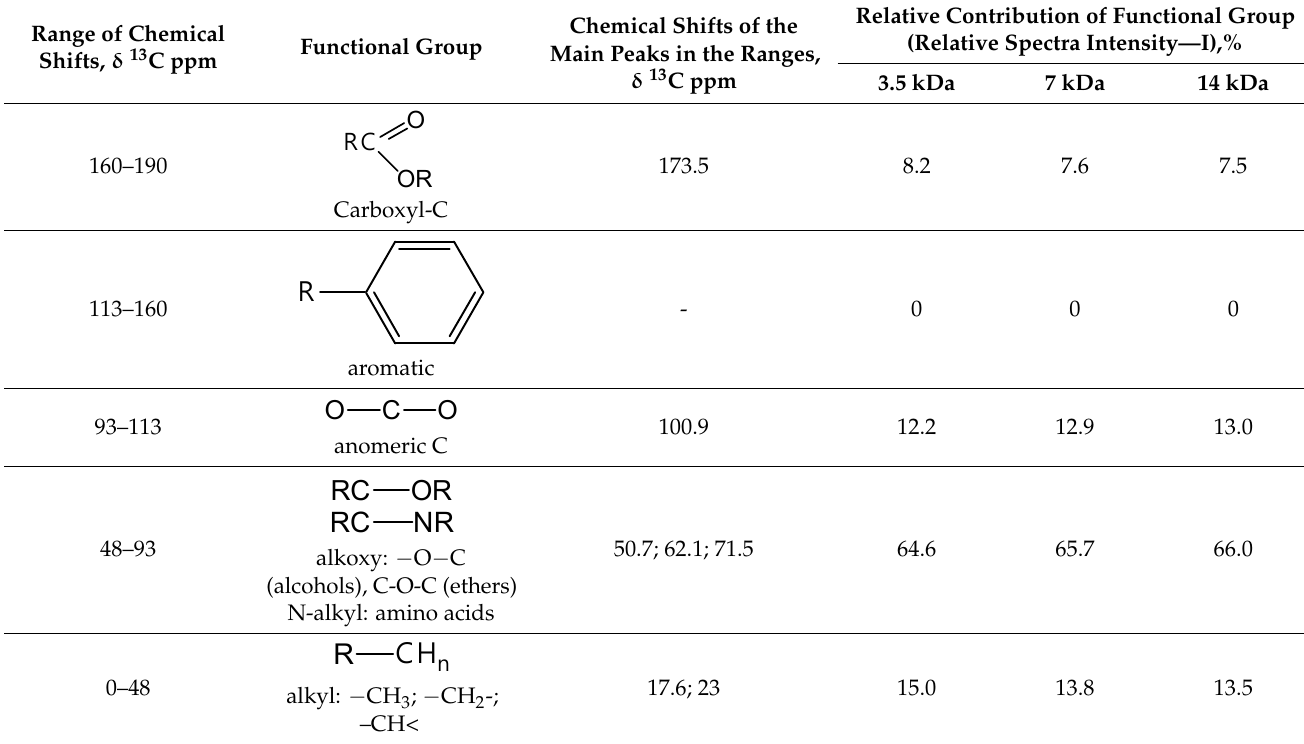
Table 2. 13 C MAS NMR spectroscopy data for the most important structural elements of HMWDOM.